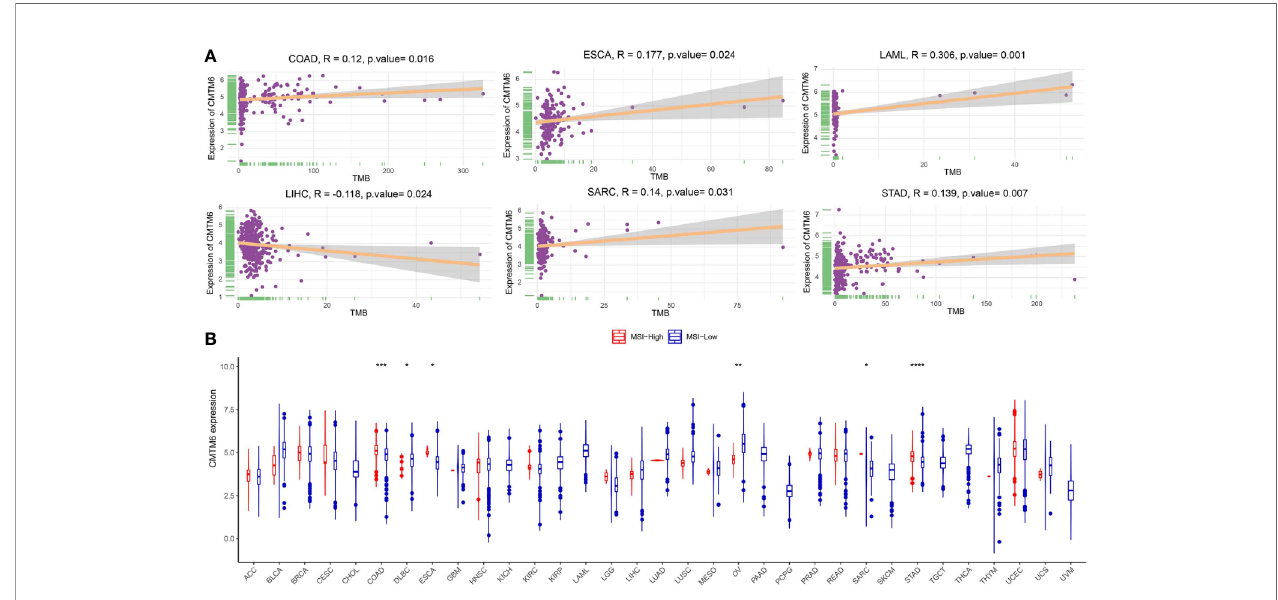
FIGURE 4 | Correlation of CMTM6 expression with tumor mutational burden (TMB) and microsatellite high instability (MSI-H). (A) CMTM6 expression was associated with TMB in colon adenocarcinoma (COAD), esophageal carcinoma (ESCA), acute myeloid leukemia (LAML), liver hepatocellular carcinoma (LIHC), sarcoma (SARC), and stomach adenocarcinoma (STAD). (B) CMTM6 expression was associated with MSI-H in colon adenocarcinoma (COAD), lymphoid neoplasm diffuse large B-cell lymphoma (DLBC), esophageal carcinoma (ESCA), ovarian serous cystadenocarcinoma (OV), sarcoma (SARC), and stomach adenocarcinoma